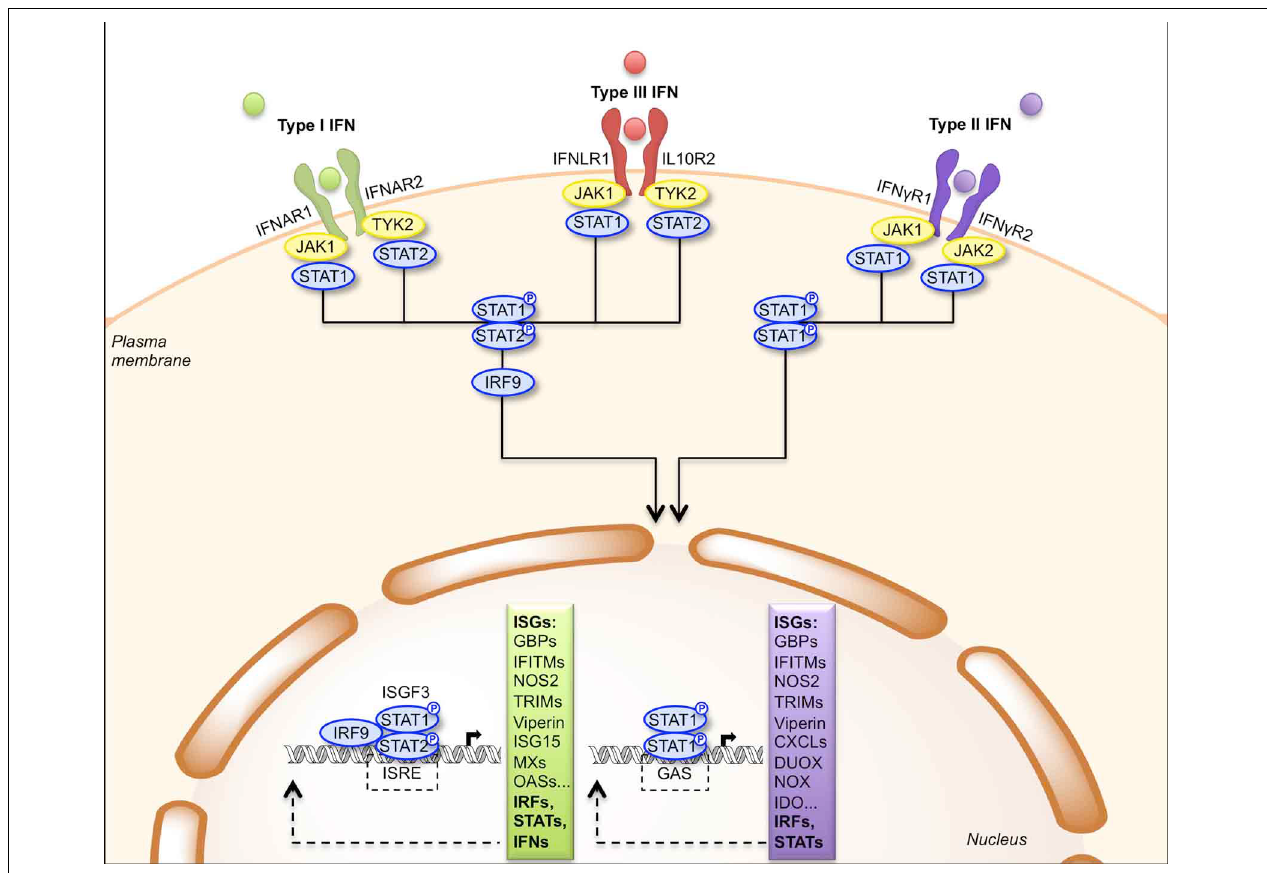
FIGURE 2 | Signal transduction by the type I, type II and type III IFN receptors. Engagement of type I and type III IFNs by their respective receptors, IFNAR1/IFNAR2 and IFNLR1/IL10R2, triggers phosphorylation of JAK1/TYK2 kinases that activate STAT1 and STAT2. Phosphorylated STAT1/STAT2 heterodimers bind IRF9 forming the ISGF3 complex, which translocates to the nucleus where it induces expression of genes with ISRE-dependent promoters. Engagement of type II IFN by the IFN γ R1/IFN γ R2 receptor induces phosphorylation of JAK1/JAK2 kinases that activate STAT1. Phosphorylated STAT1 homodimers translocate to the